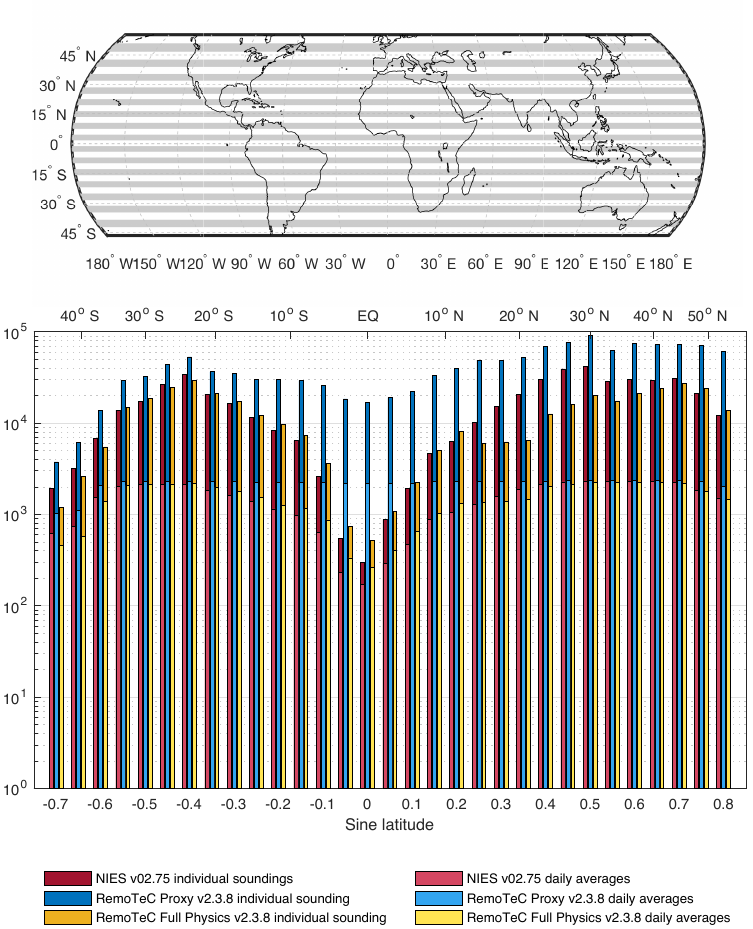
Figure 10. Illustration of the studied latitude bands (the uppermost panel). Bands are in intervals of 0.05 sine of latitude between sine of latitude − 0.70 to 0.80, i.e between latitudes 44.43 ◦ S and 53.13 ◦ N. Number of individual soundings and daily averages for NIES, RemoTeC Proxy and RemoTeC FP retrievals at all of the studied latitude